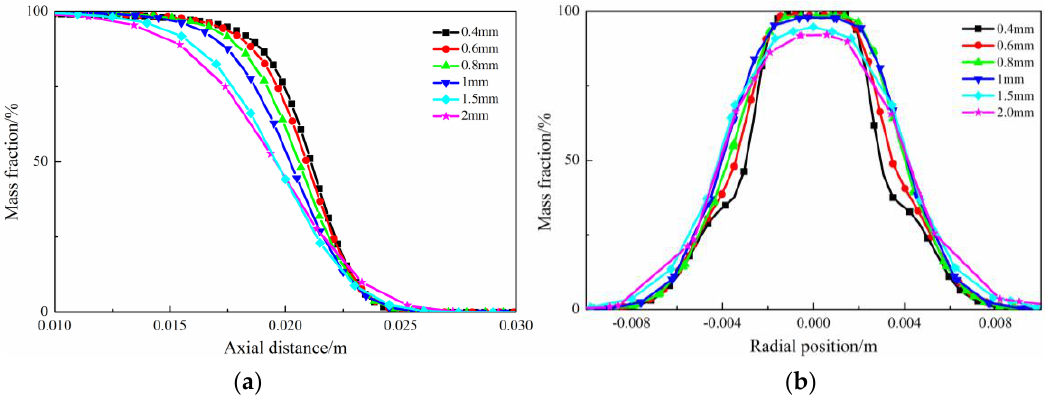
Figure 4. Results of grid independency check ( a ) Mass fraction distribution along the exit axis; ( b ) Mass fraction distribution in the radial direction.